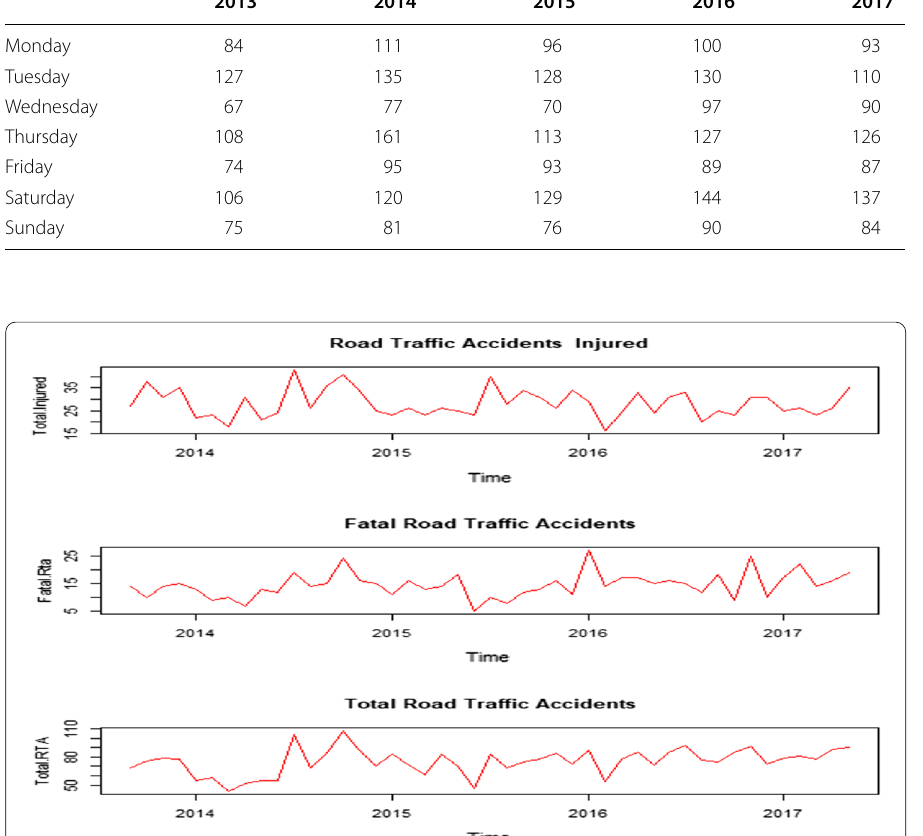
Fig. 1 Time series plot of monthly reported Injury, fatal and total road traffic accidents in Amhara Region (September 2013 to May